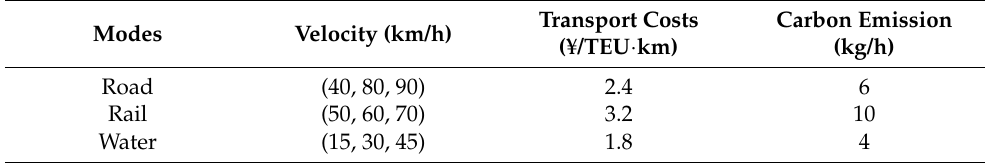
Table 3. Basic information for different transportation modes.